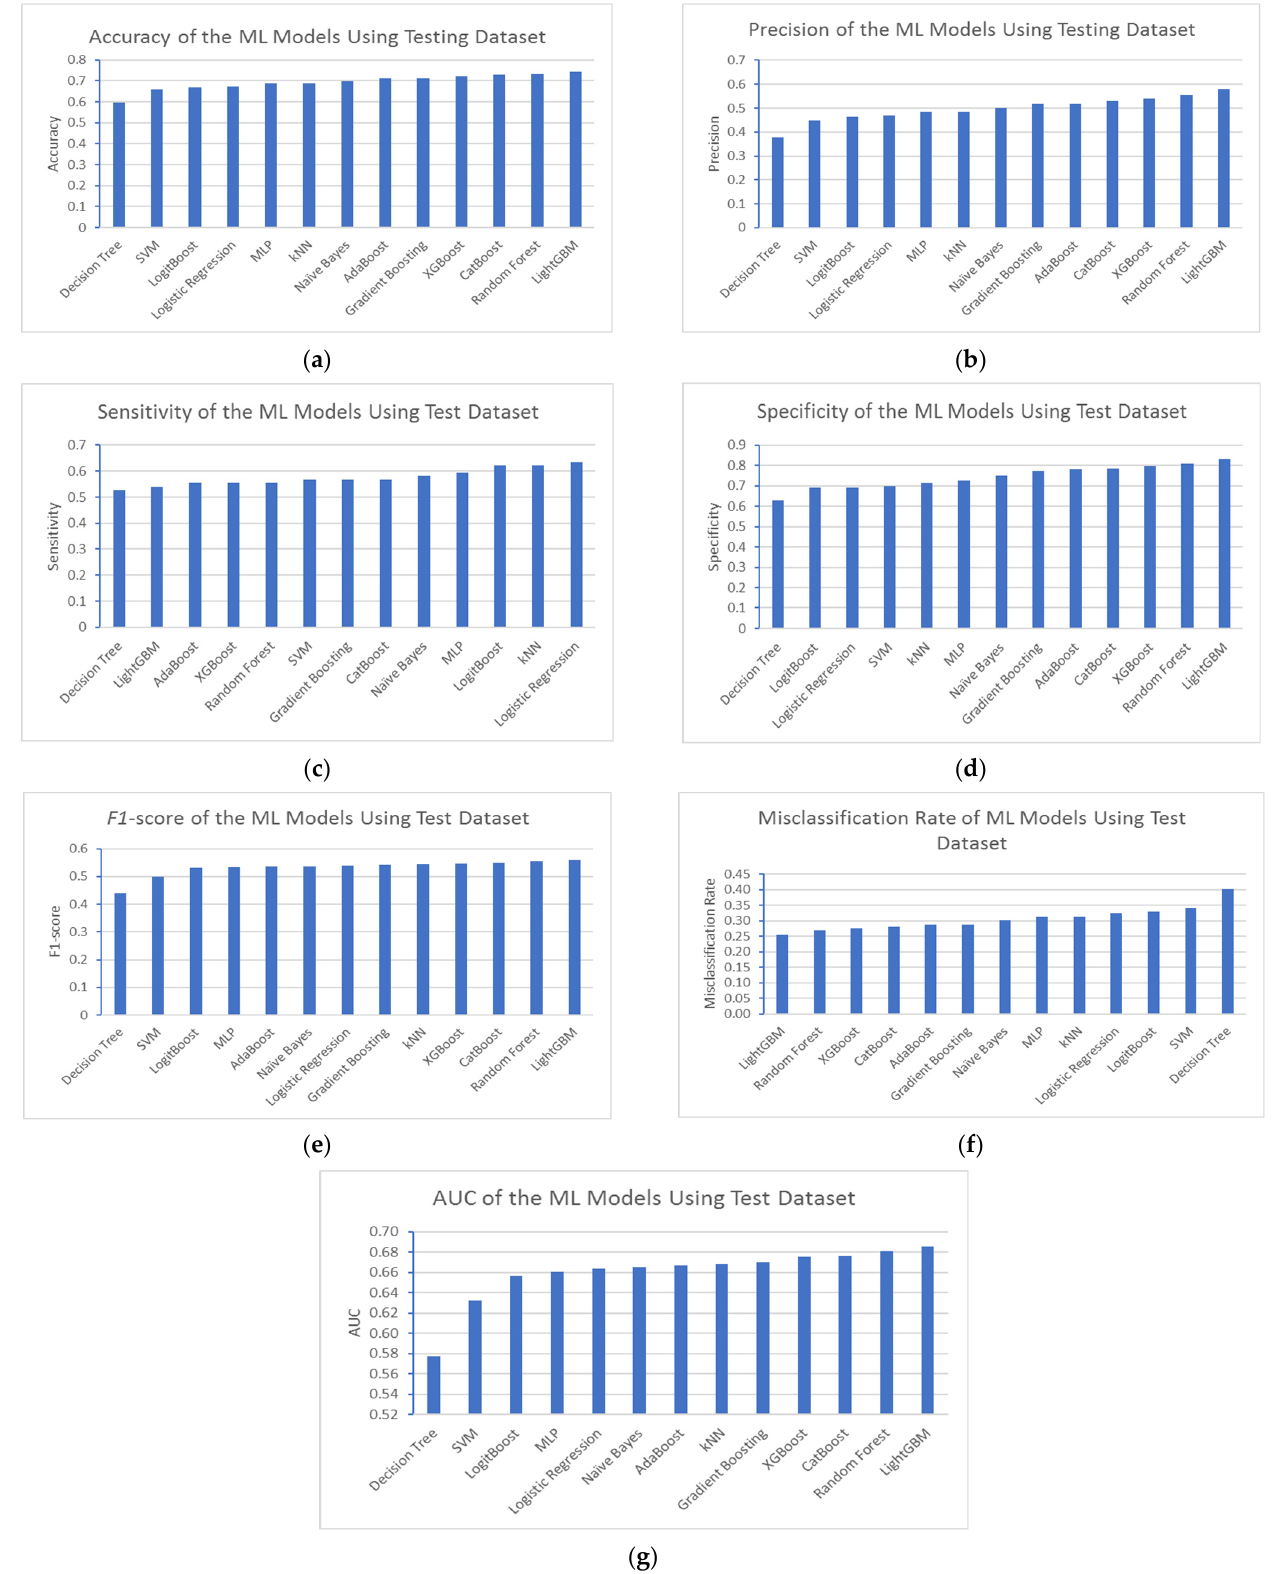
Figure 4. Bar graphs showing the performances of the trained models for the different performance measures: ( a ) accuracy, ( b ) precision, ( c ) sensitivity, ( d ) specificity, ( e ) F1 -score, ( f ) misclassification rate, and ( g ) AUC.